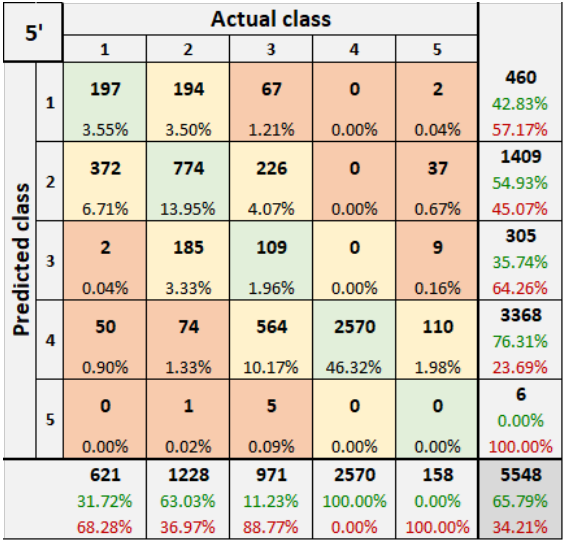
Figure 6. Confusion matrix corresponding to a time horizon of 5 min.